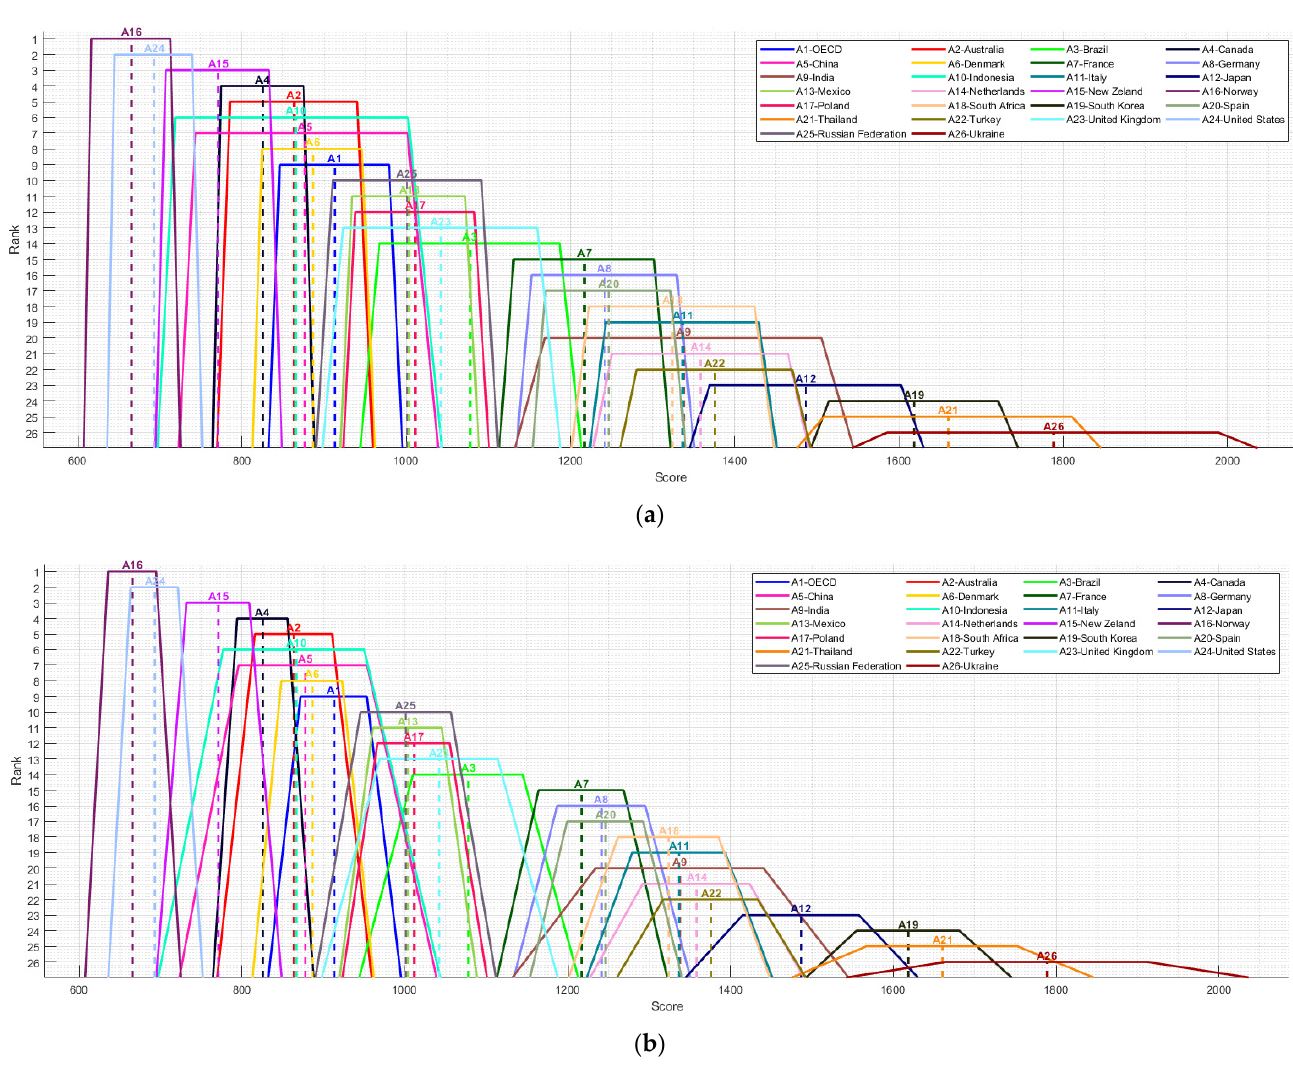
Figure 2. IESRI ranking obtained on the basis of predicted metric values, using TFNs constructed using: ( a ) standard deviation based fuzzification, ( b ) half distance based fuzzification.